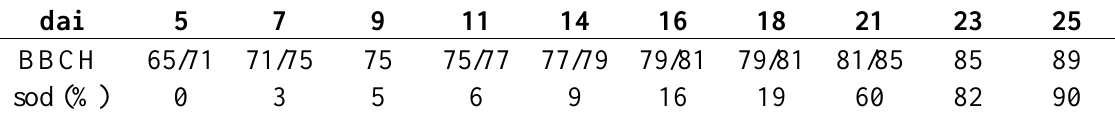
Table 1. Representative example of plant development (BBCH stage) and rated disease symptoms of head blight (severity of disease, sod, n =